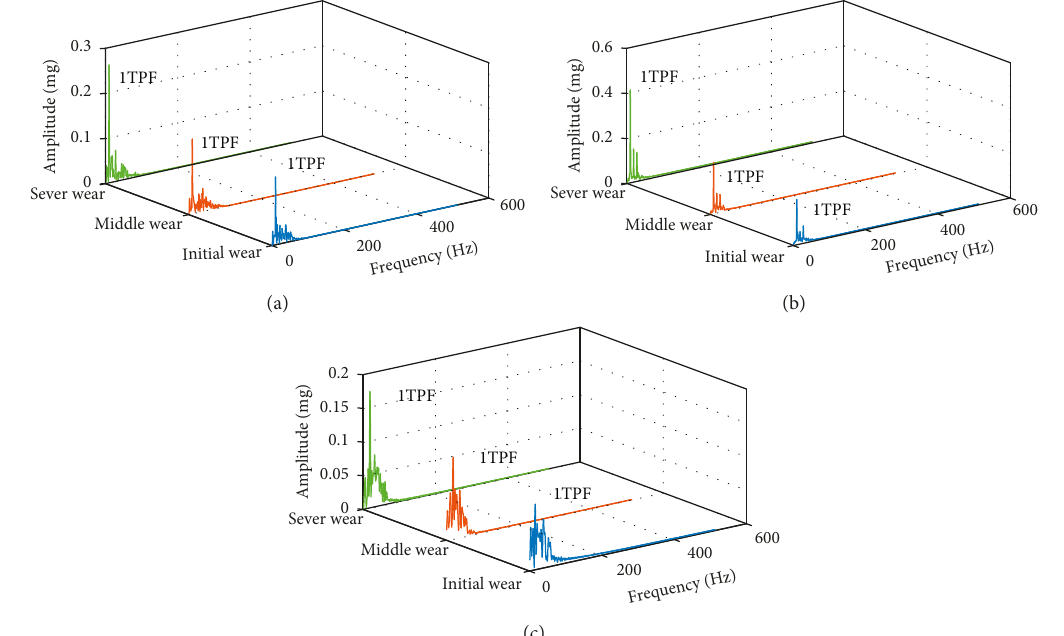
Figure 8: Spectrogram of vibration signals in different tool wear states: (a) X -directional vibration signals, (b) Y -directional vibration signals, and (c) Z -directional vibration